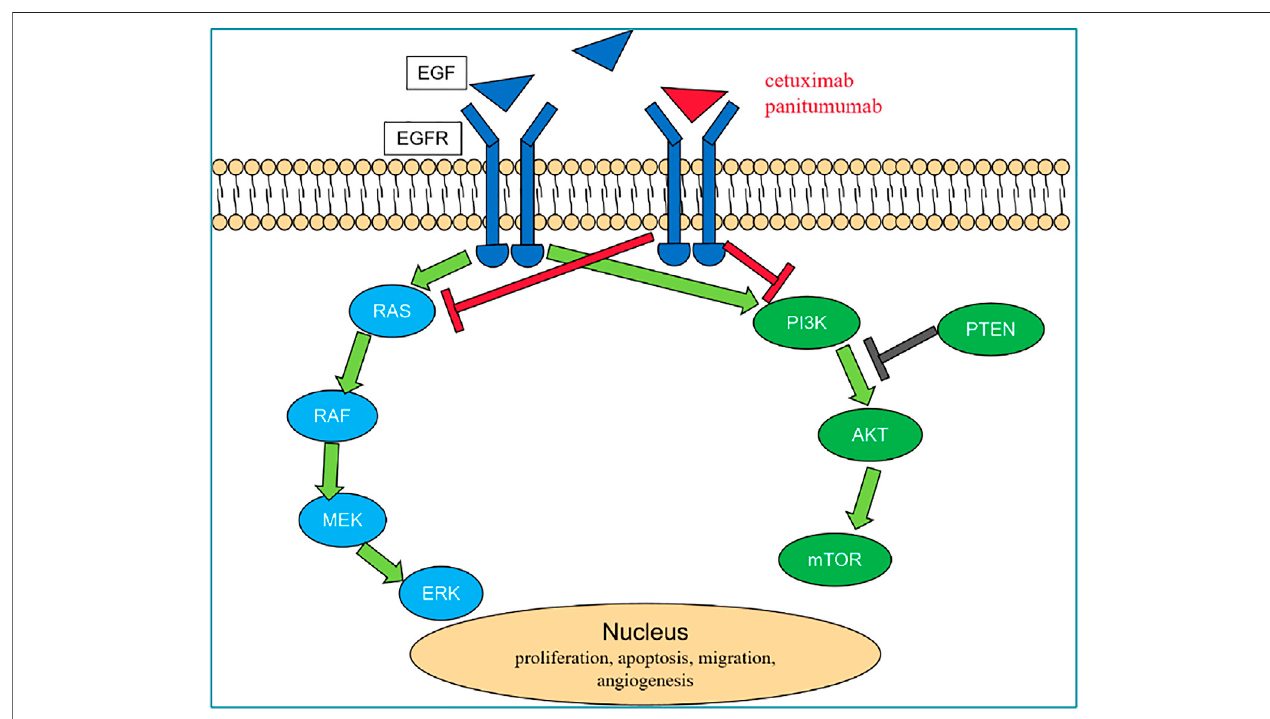
FIGURE2| EGFRpathway.Inmalignantcells,EGFcombinetoEGFRandactivatetheEGFRpathway whichinitiatesadownstream signalingcascadethroughthe RAS/RAF/MAPK and the PI3K/AKT/mTOR axes and then promotes cell proliferation. Cetuximab and panitumumab are anti-EGFR mAbs, which by competitivebinding to the extracellular domain of EGFR lead to the internalization, degradation of the receptor, and inhibition of the EGFR signal transduction pathway and also through the antibody-dependent cytotoxic effect inhibit the proliferation of tumor cells and induce apoptosis, so as to achieve the effect of tumor control. Abbreviations: AKT, AKT8 virus oncogene cellular homolog; EGFR, epidermal growth factor receptor; ERK, extracellular signal-regulated kinase; MEK, mitogen-activated protein kinase; mTOR, mammalian target of rapamycin; PI3K, phosphatidyilinositol 3-kinase; PTEN, phosphatase and tensin homolog; RAF, v-Raf murine sarcoma viral oncogene homolog; and RAS, rat sarcoma viral oncogene